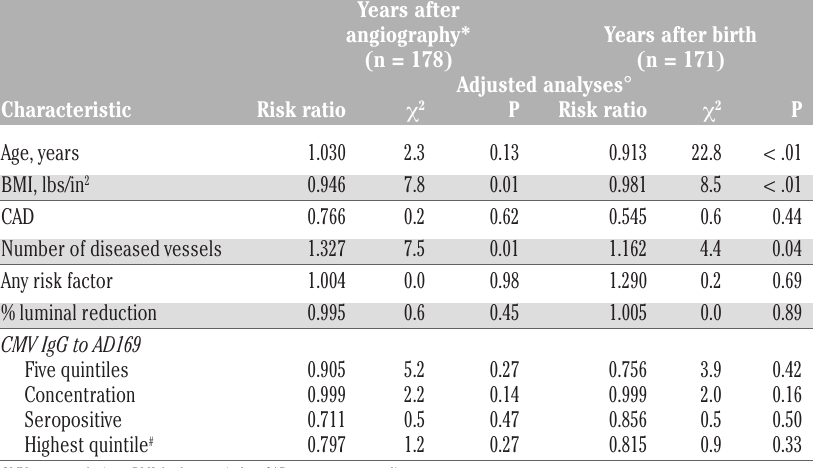
Table 4. Survival analysis of patients 70 years or older by cytomegalovirus igG to